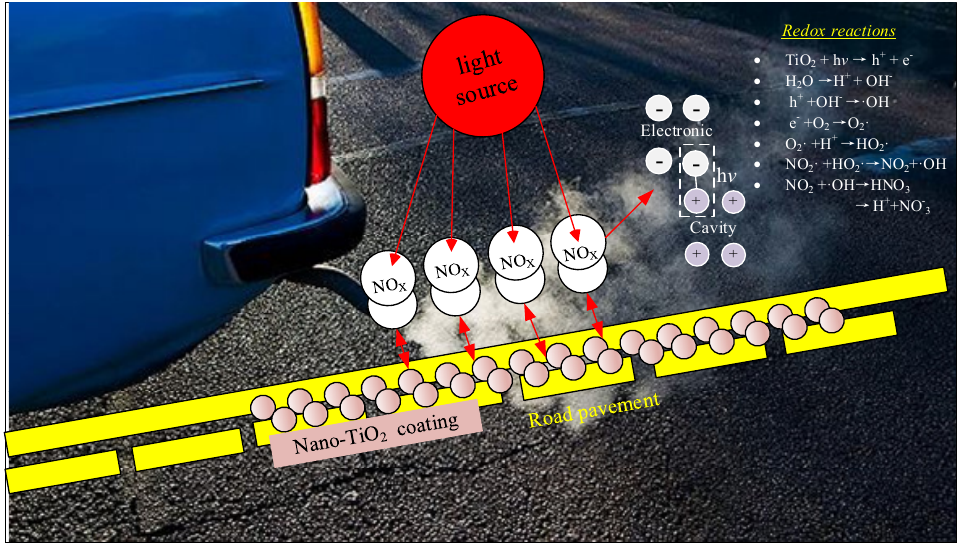
Figure 3. Catalytic principle of Nano-TiO 2 coatings.